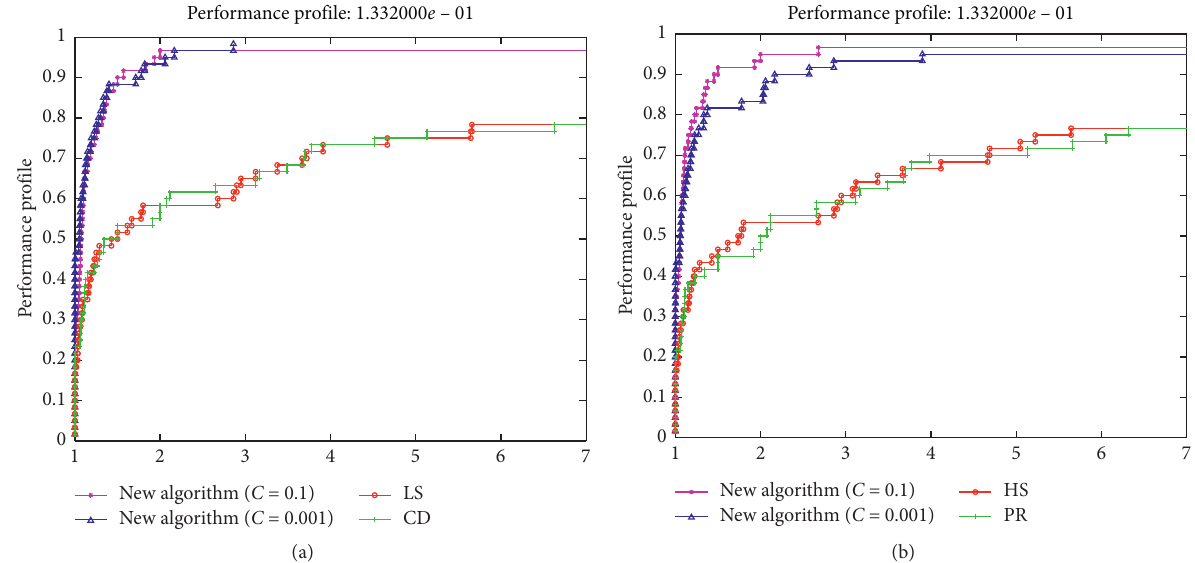
Figure 3: Performance profiles based on CPU Time. (a) Comparison of the new algorithm vs. LS and CD. (b) Comparison of the new algorithm vs. HS and PR.